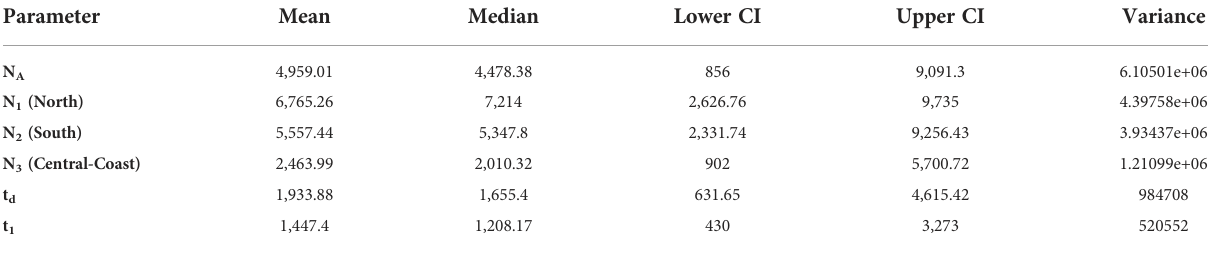
TABLE 3 Parameter estimations of the selected scenario (Scenario 7 in Figure 4 ) in the DIYABC-RF analysis.